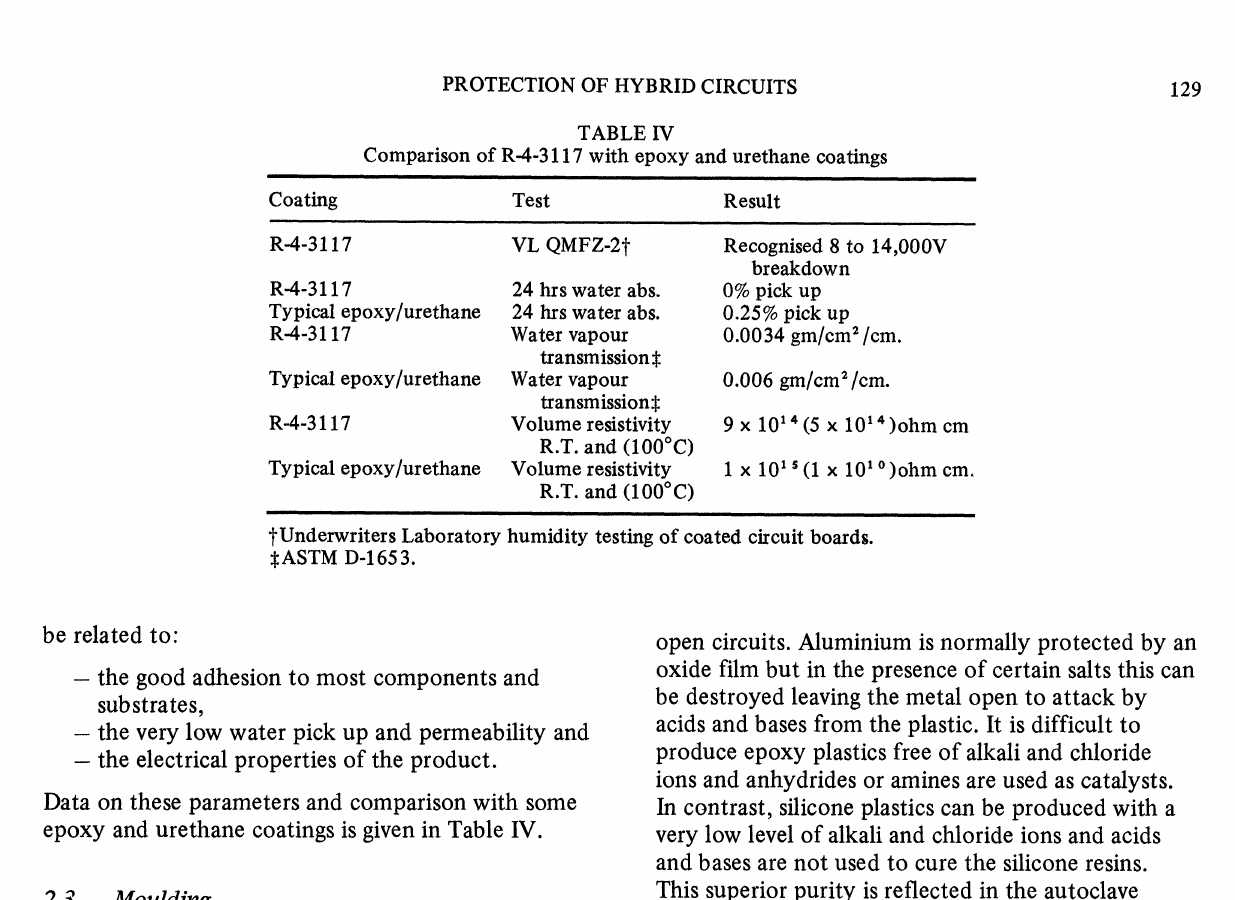
TABLE V Autoclave testing of plastic encapsulated 4011